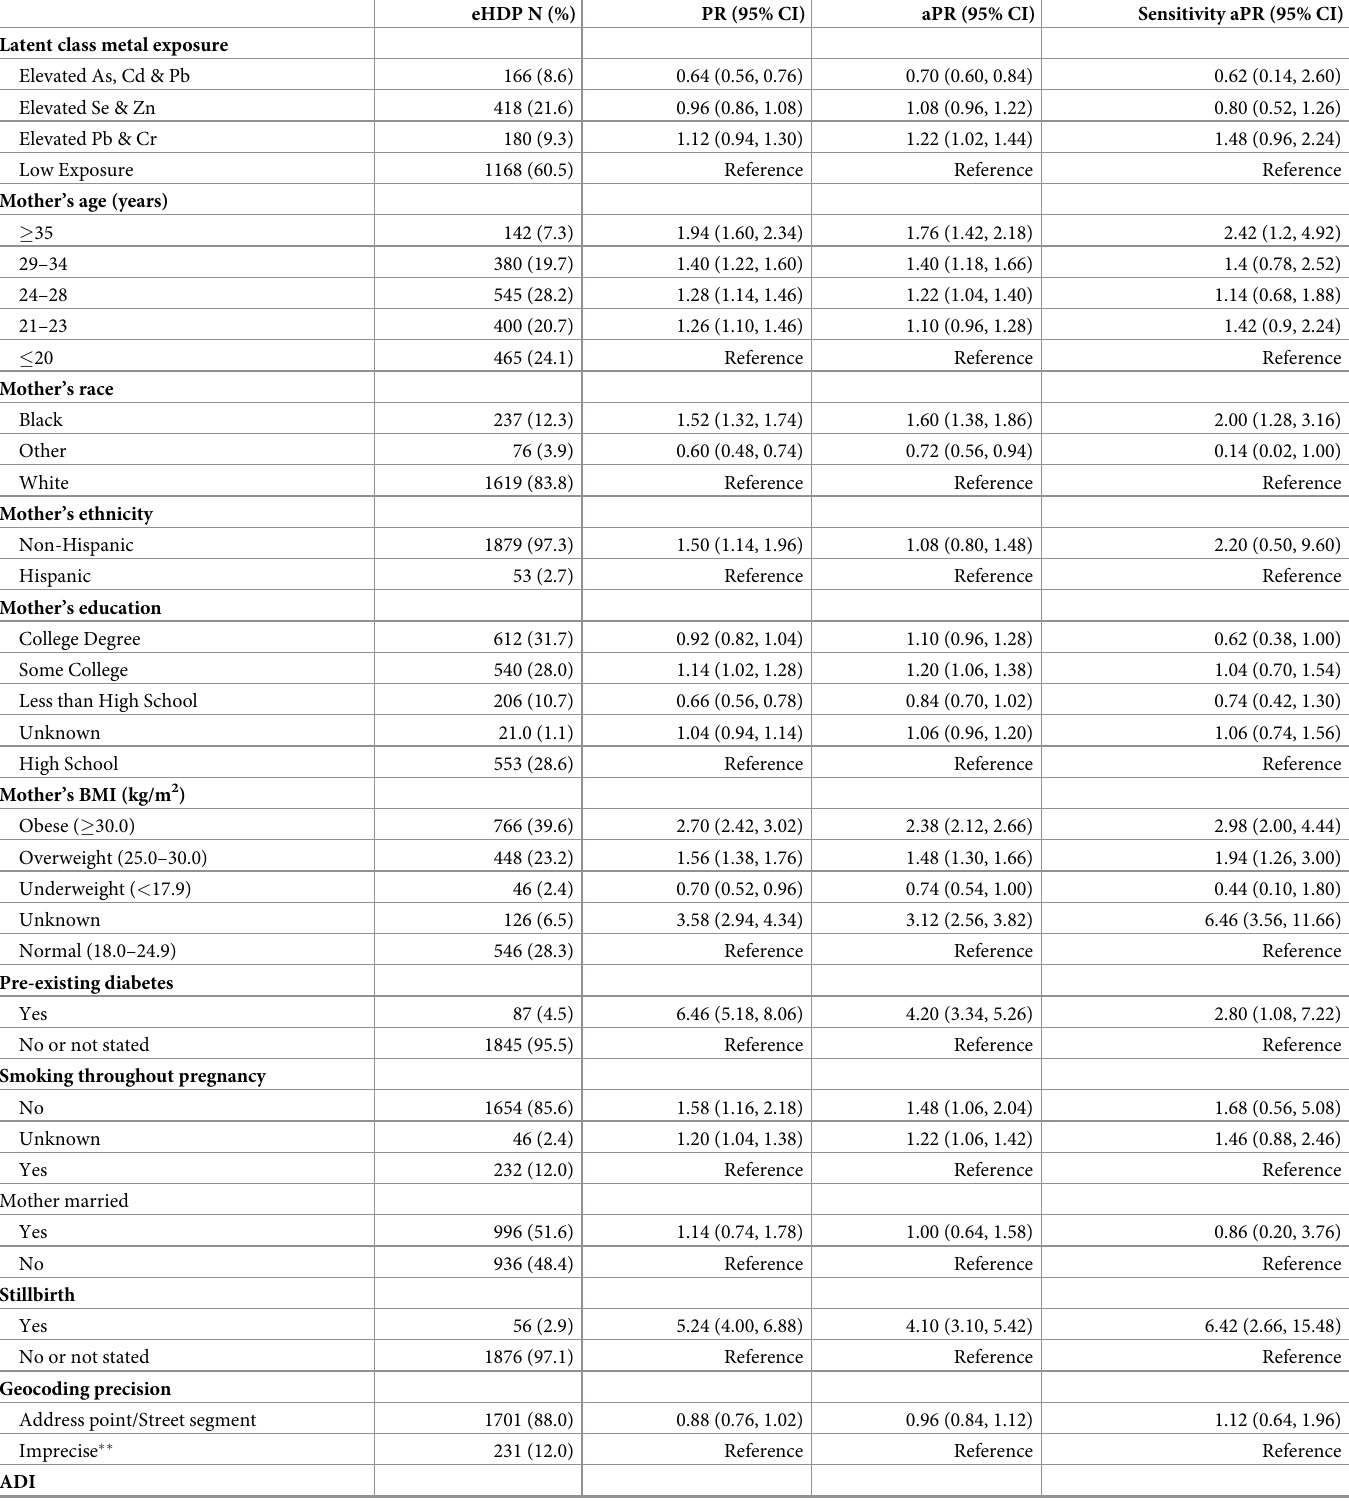
Table 3. Bivariate and multivariable associations between demographic characteristics, environmental exposures, and class